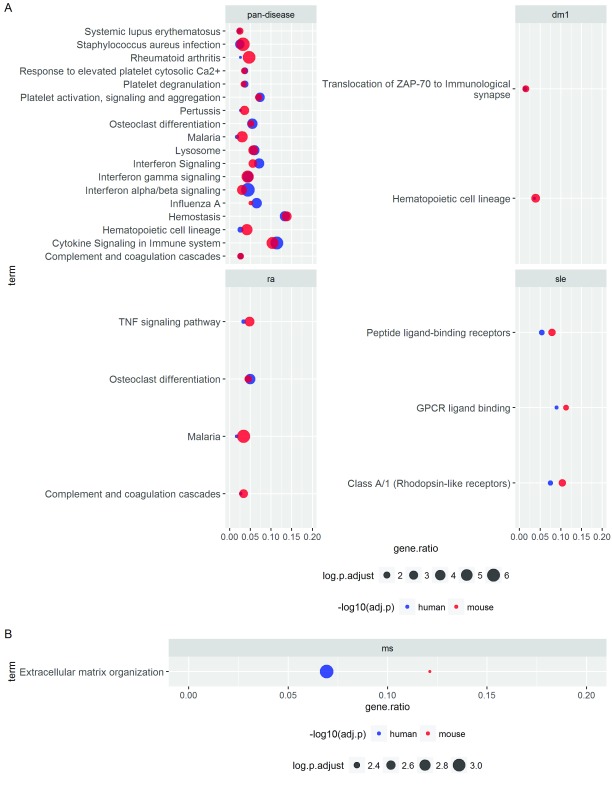
Pan-species, pan-disease signatures: Overlap of enriched biological processes between human and mouse.Over-representation analyses of the (
A) UP genes and (
B) DOWN genes (PFP <= 0.05) identified within OMiCC were carried out against KEGG and Reactome terms (see also
Figures 4 and
Figure S2 and
Table S2). For each individual CGP compendium (disease or pan-disease), gene sets or terms with adjusted p-value <= 0.05, as defined by the hypergeometric test after adjustment by the Benjamini and Hochberg (BH) FDR procedure, in both human and mouse are listed. These overlapping terms highlight signatures conserved between human and mouse. Gene ratios (x-axis) denote the fraction of genes in the respective signature (human and mouse as denote by blue and red, respectively) that are in the target gene set (y-axis).